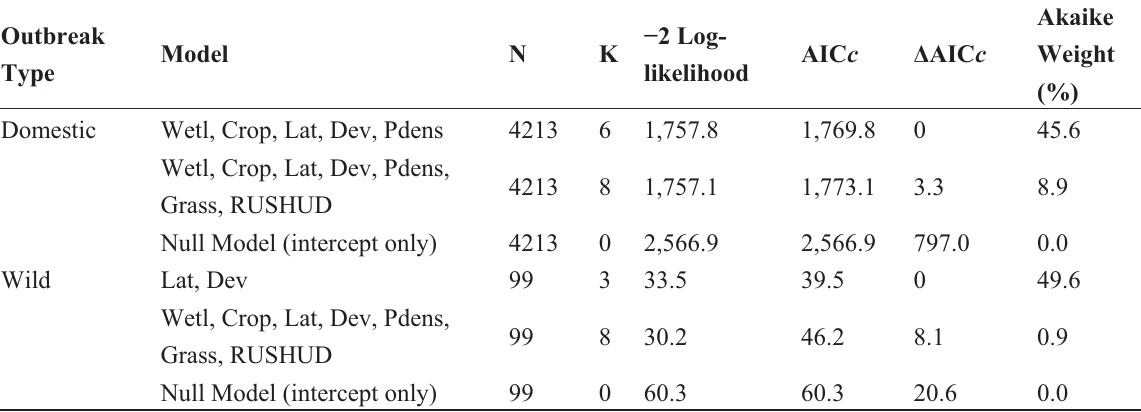
Table 4. Ranking of candidate corrected Akaike Information Criterion (AIC c ) models for domestic and wild outbreaks in the Central Asian Flyway. Sample size, variables, − 2 log-likelihood, AIC c , delta AIC c , and Akaike weights are reported. Ranking of AIC c models to compare domestic poultry and wild bird highly pathogenic avian influenza H5N1 disease outbreak sites against random locations within the migratory pathway of ruddy shelducks marked at Qinghai Lake, China, 2007 – 2008. Backward and forward stepwise methods were used to select the best model for each wild and domestic outbreaks with different combinations of the seven predictor variables, presented with the full model (all variables) and the null model (intercept only). Variables include percent wetland (Wetl), cropland (Crop), developed land (Dev), and grassland (Grass), as well as latitude (Lat), poultry density (Pdens), and a seasonal utilization distribution for satellite-marked ruddy shelducks (RUSHUD).